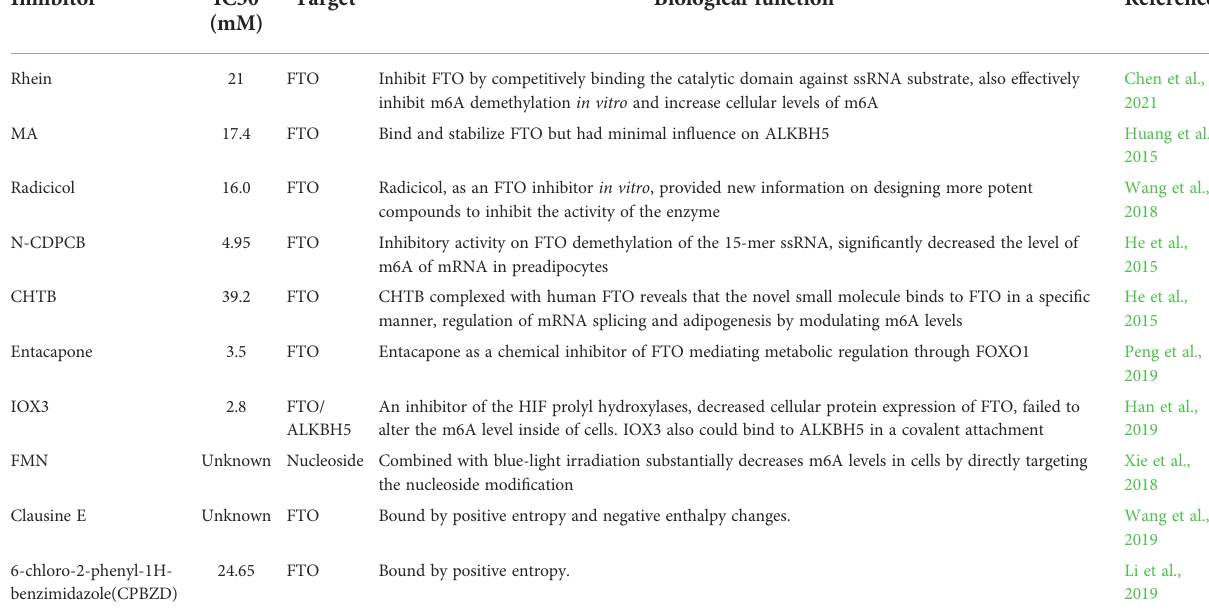
TABLE 2 The inhibitors of m6A-related enzymes and their biological